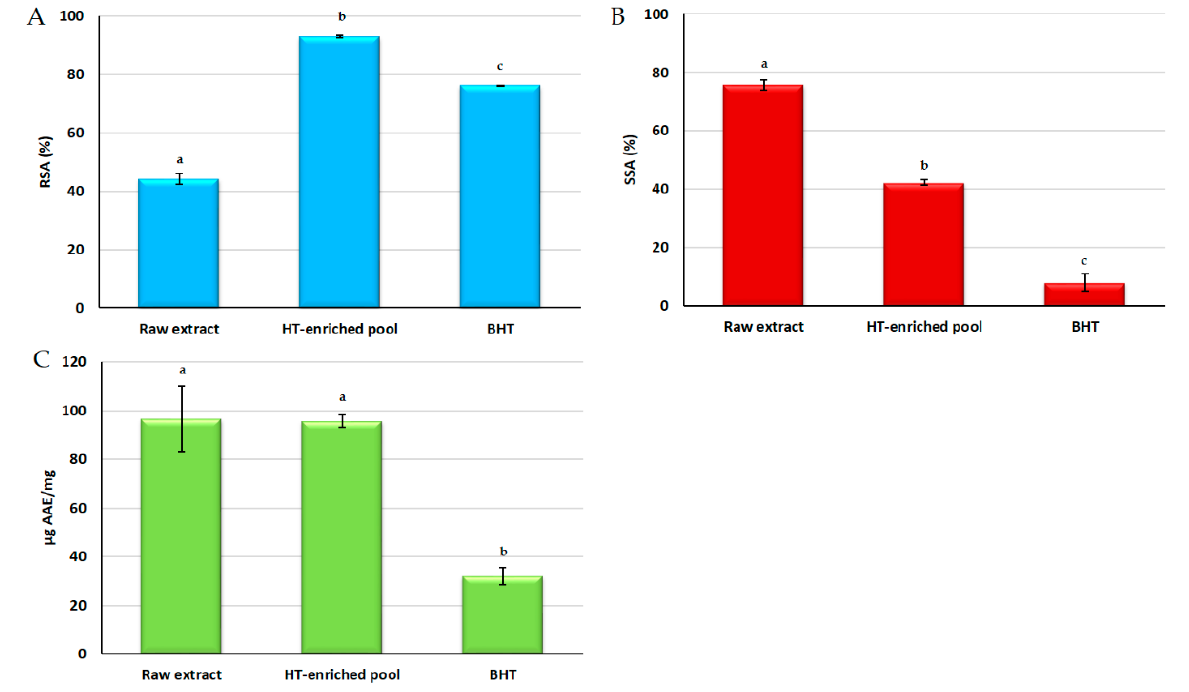
Figure 3. Antioxidant power of OOD raw extract and HT-enriched pool prepared by means of XAD7HP resin, according to Method 3, as described in Section 2.3. RSA: Radical scavenging activity ( A ), SSA: Superoxide scavenging activity ( B ), FRAP: Ferric reducing antioxidant power ( C ). BHT: butylatedhydroxytoluene; AAE: Ascorbic acid equivalent. Bars with different letters indicate significant differences at p < 0.001 (RSA and SSA) and p < 0.0001 (FRAP).